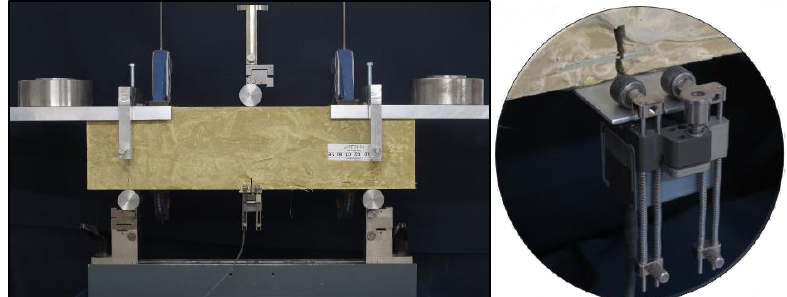
Figure 3. Specimen viewed from the side during the test—CMOD (crack mouth opening displacement) measured using a precision extensometer.